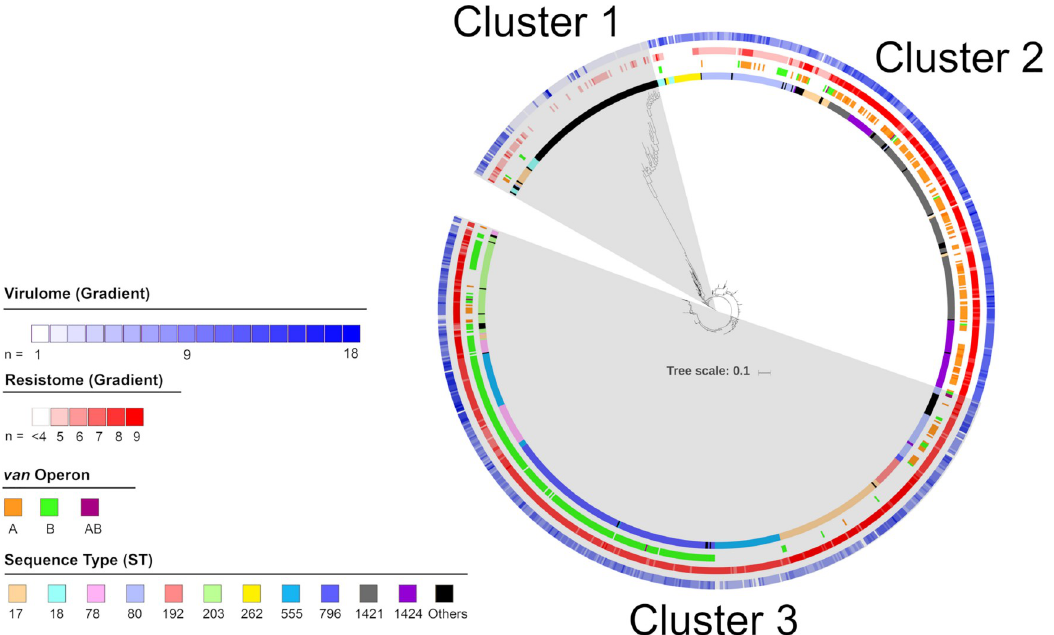
Fig 1. Maximum likelihood phylogenetic tree based on single nucleotide polymorphisms grouped all Enterococcus faecium isolates into three clusters. From the outermost ring: Number of virulence factors, number of antimicrobial resistance genes not including the van operon, type of van operon and major sequence types are highlighted as per